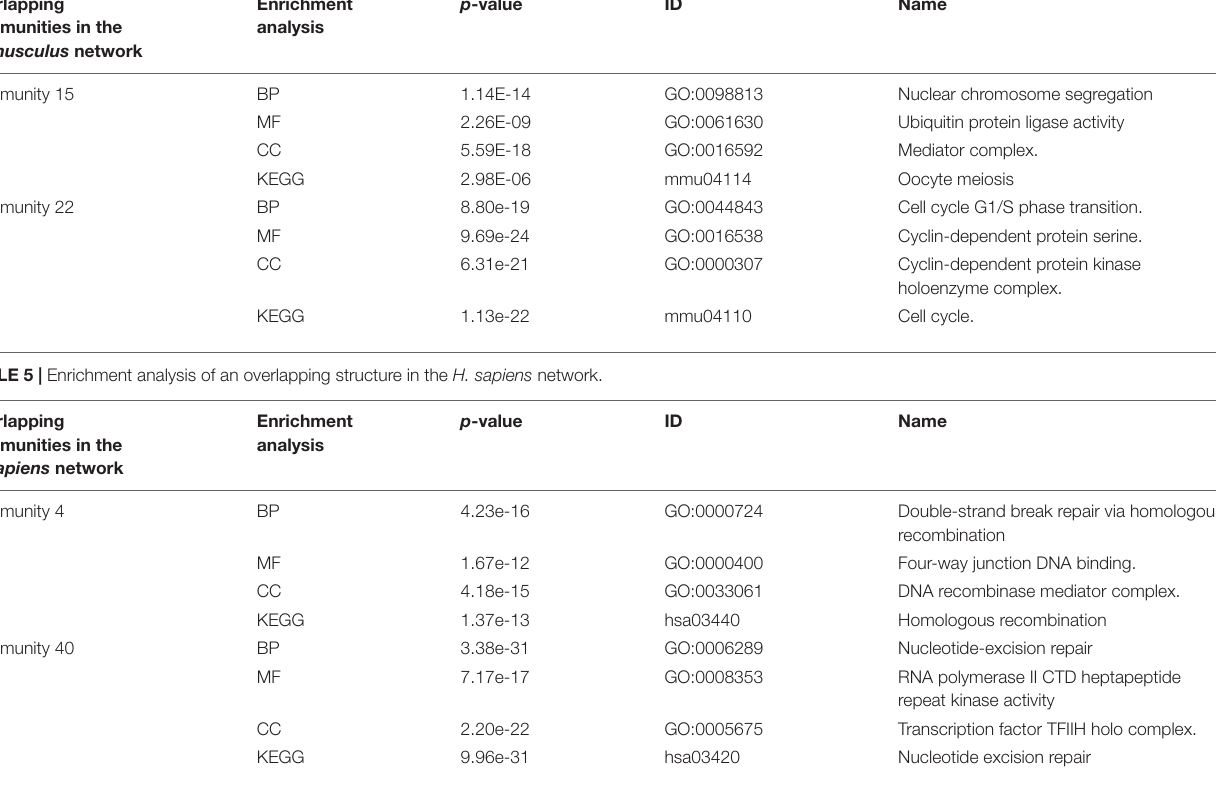
TABLE 4 | Enrichment analysis of an overlapping structure in the M. musculus network. Overlapping communities in the